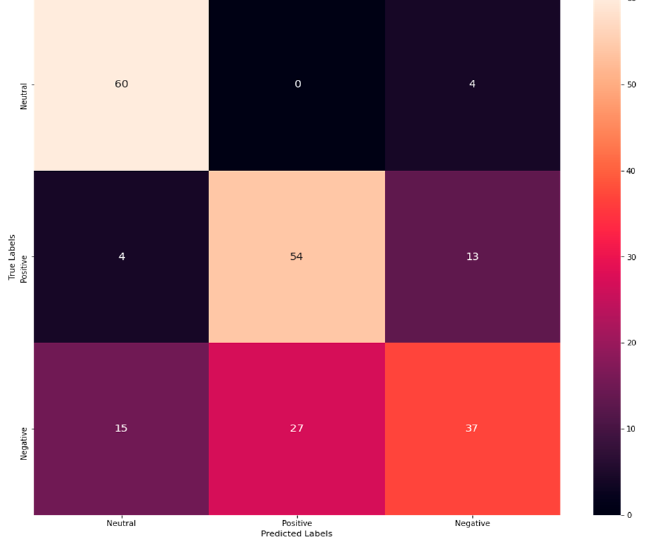
Figure 5. Confusion matrix of